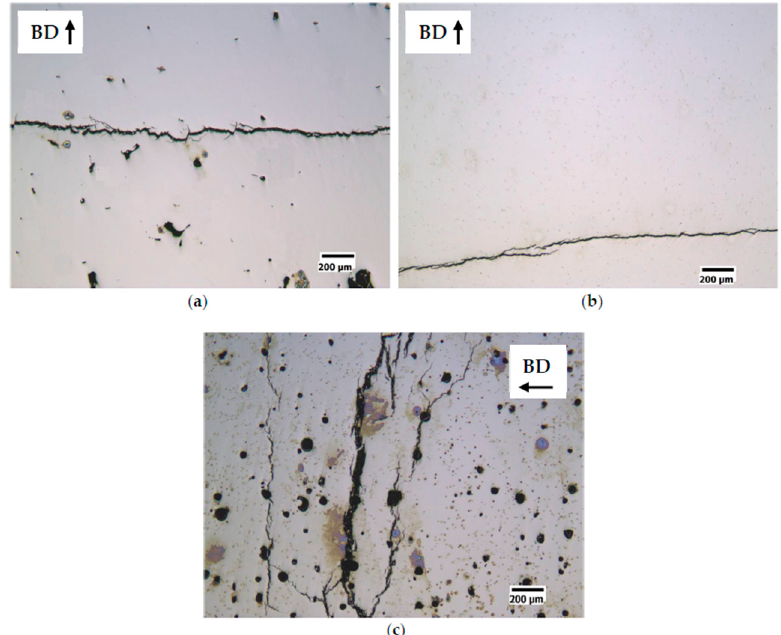
Figure 7. Effect of the specific laser energy E (Jm − 1 ) on the densification of FeSi6.5 steel samples. ( a ) sample S1 ( E = 150 Jm − 1 , v = 0.5 ms − 1 , P = 75 W), relative density of the sample 99.93% and pores with irregular shape; ( b ) sample S3 ( E = 200 Jm − 1 , v = 0.835 ms − 1 , P = 167 W), relative density of the sample 99.99%; ( c ) sample S18 ( E = 350 Jm − 1 , v = 0.5 ms − 1 , P = 175 W), relative density of the sample 99.98% and pores with spherical shape.